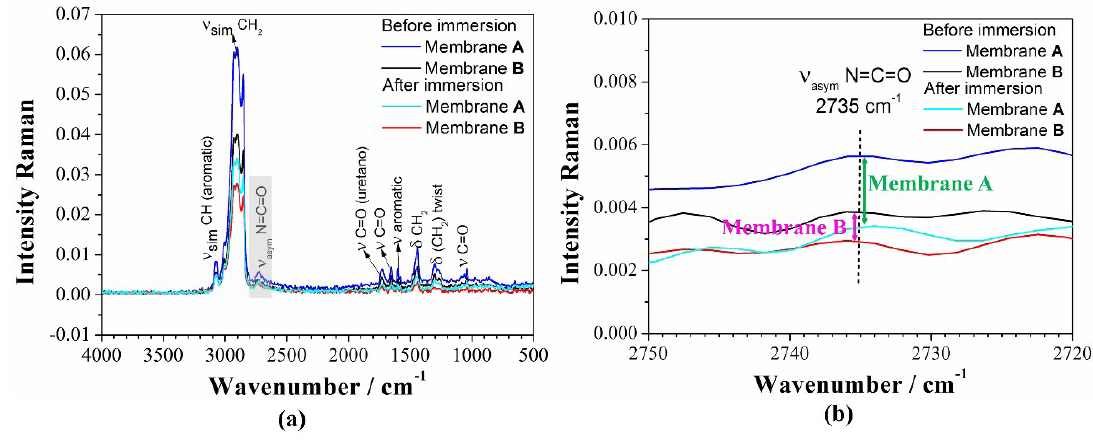
Figure 4. (a) Raman spectra obtained for membranes A and B before and after immersion in 0.1 mol/L KCl for 7 days and (b) zoom-in of the band for N=C=O group.